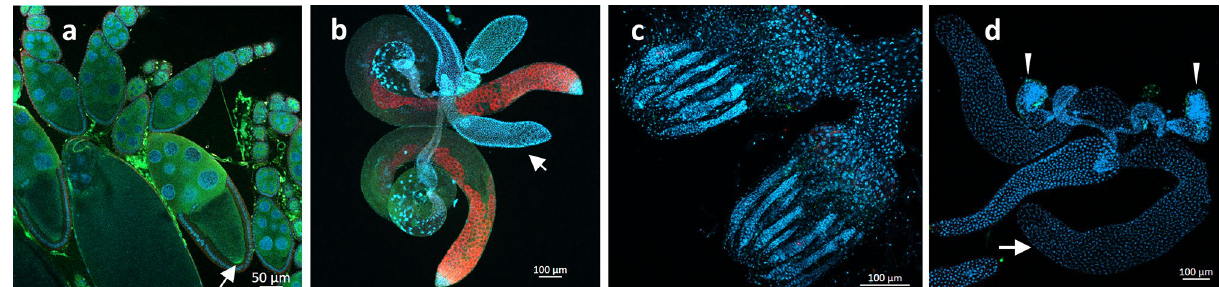
Figure 6. Germinal-specific siRNAi simultaneous knockdowns of both germinal and ubiquitous NACα disrupt the development of testis and oogenesis leading to complete infertility. DNA is stained with DAPI (blue), gNACβ (red), VASA (green). ( a ) Normal ovaries, the arrow indicates stage 9 of oogenesis and VASA expression in the nurse cells and posterior oocyte pole. ( b ) Normal testis, gNACβ immunostaining of spermatocytes, unstaining of somatic accessory glands (arrow) and seminal vesicles. (c , d) Adult ovaries and testes, images of double germinal knockdowns of germinal (gNACα ) and ubiquitous (ubNACα) NACα genes using nos- Gal4 > UAS-gNACα-ubNACα-RNAi. ( c ) The image of double germline knockdowns in ovaries showing DAPI stained somatic residues of elongated ovarioles lacking germinal cells. ( d ) Elimination of germinal cells and testes, the arrow points to the accessory gland, the arrowhead points to testis somatic